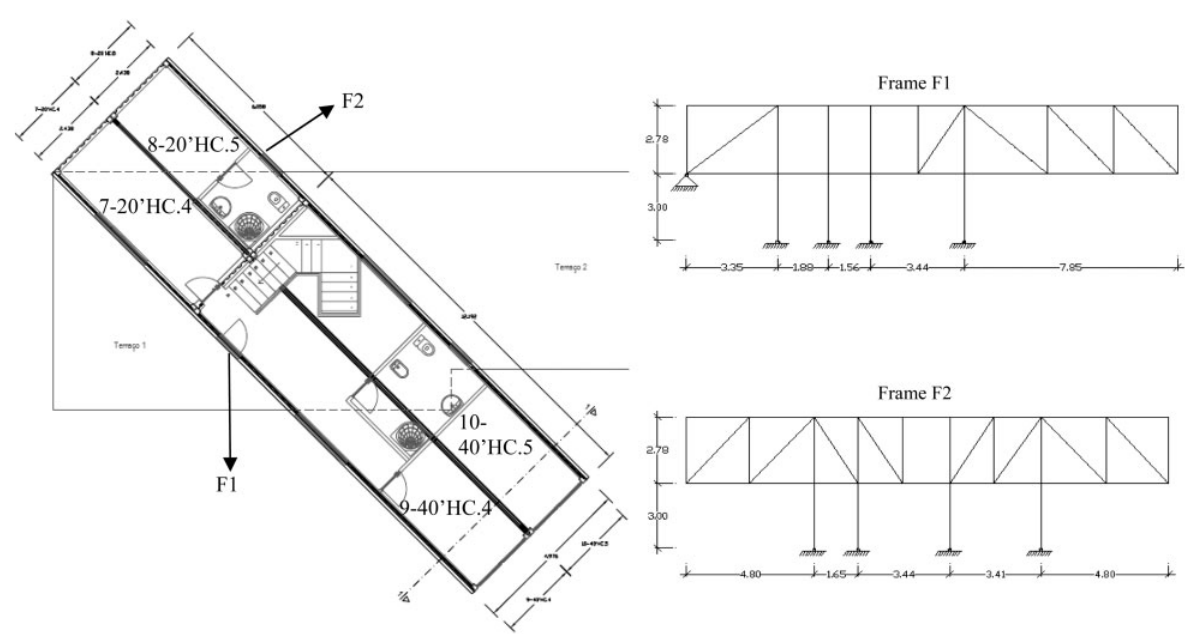
Fig. 13. Configuration with external trusses: Floor